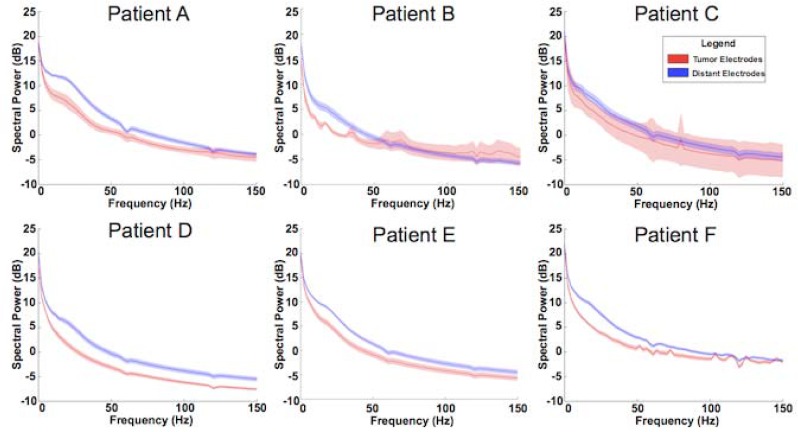
Power spectra comparing tumor (red) and distant (blue) spectral densities from each individual subject.